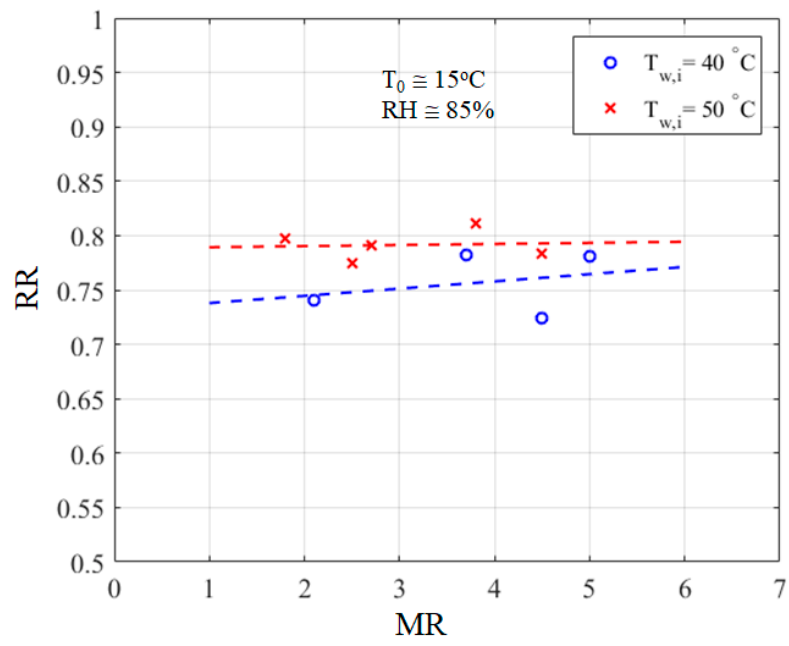
Figure 8. Recovery ratio (RR) as a function of MR .